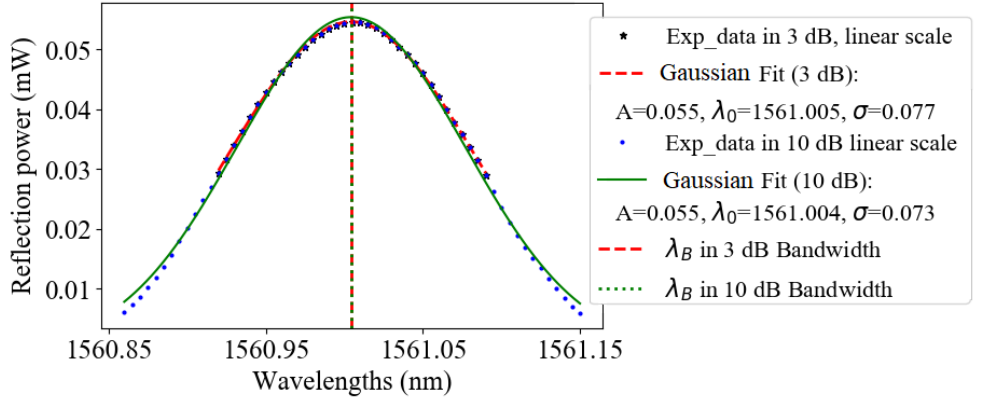
Figure 7. Gaussian fit example for data points on linear scaled data points in 3 and 10dB